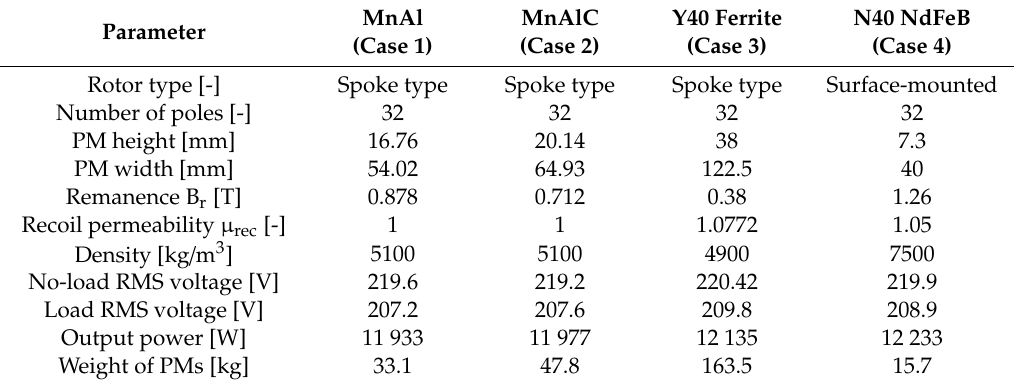
Table 4. Rotor parameters of the